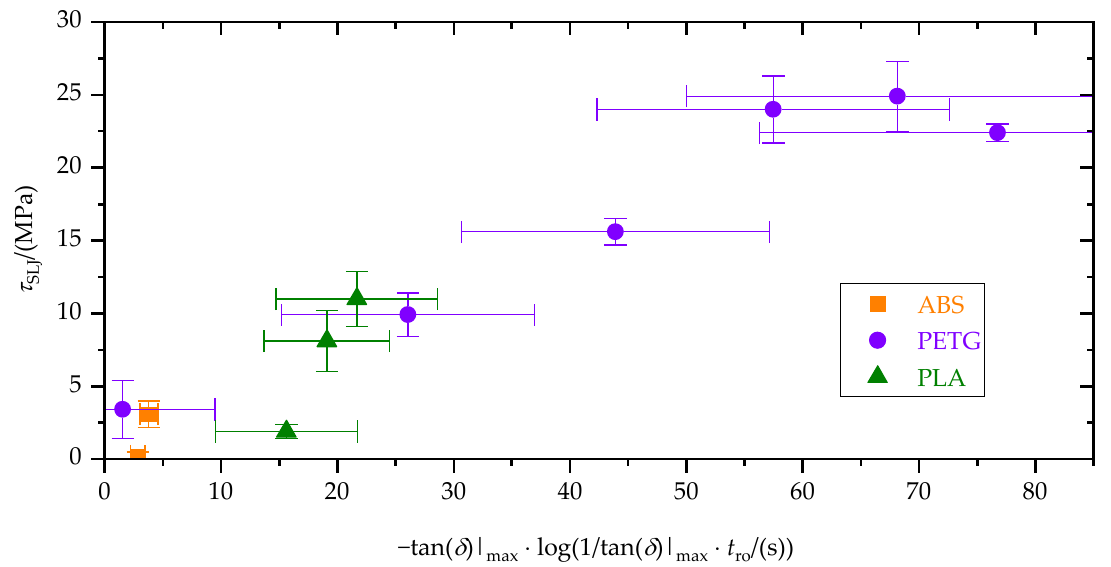
Figure 15. Tensile single-lap-shear strength, τ SLJ , as a function of the rheologically derived quantities of Rouse relaxation time, t ro , and maximum loss factor, tan( δ )| max .